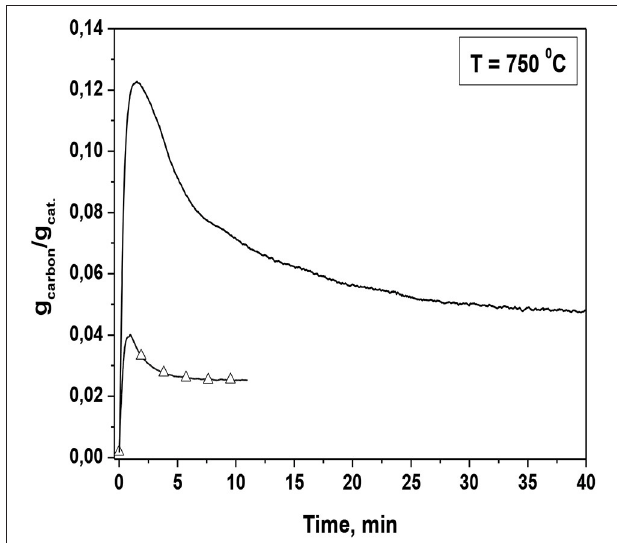
FIGURE 5 | Long-term TG analysis of blank ( – ) Ni/GDC and (- △ -) 3 wt.% Au-Ni/GDC (D.P.) powders. The measurements were carried out isothermally at 750 ◦ C under CH 4 steam reforming conditions with 16 vol% CH 4 /Ar, 10 vol% H 2 O in Ar for Ni/GDC and with 20 vol% CH 4 /Ar, 10 vol% H 2 O in Ar for 3 wt.% Au-Ni/GDC (D.P.). Reprinted with permission from Niakolas et al.